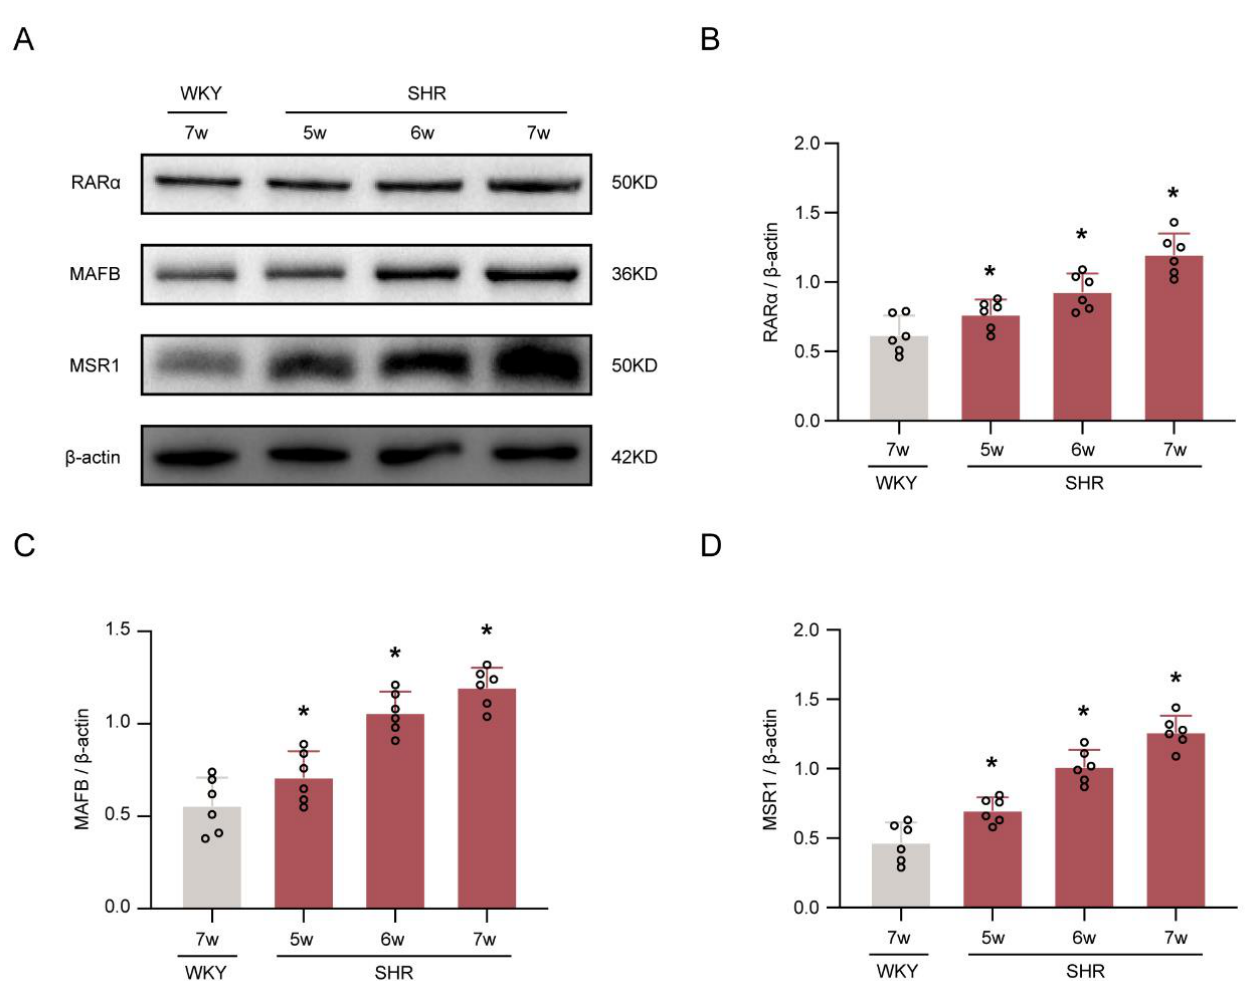
Figure 2. Temporal expression of RAR α , MAFB, and MSR1 in SHRs. ( A ) Representative Western Figure 2. T emporal expression of RARα, MAFB, and MSR1 in SHRs. ( A ) Representative Western blotting images of RAR α , MAFB, and MSR1. ( B – D ) Quantitative analyses of RAR α , MAFB, and blot ting images of RARα, MAFB, and MSR1. ( B – D ) Quantitative analyses of RARα, MAFB, and MSR1. n = 6. * p < 0.05 versus WKY rats at week 7. Values are means ± MSR1. n = 6. * p < 0.05 versus WKY rats at week 7. Values are means ± SD.